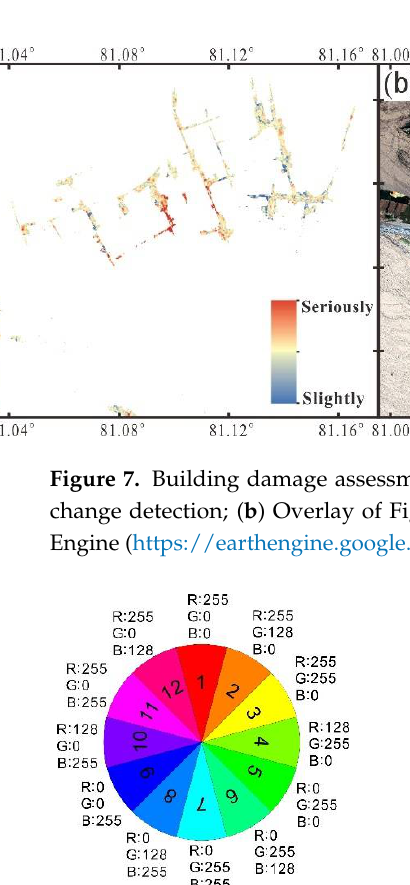
Figure 8. RGB color synthesis results in partial colors.